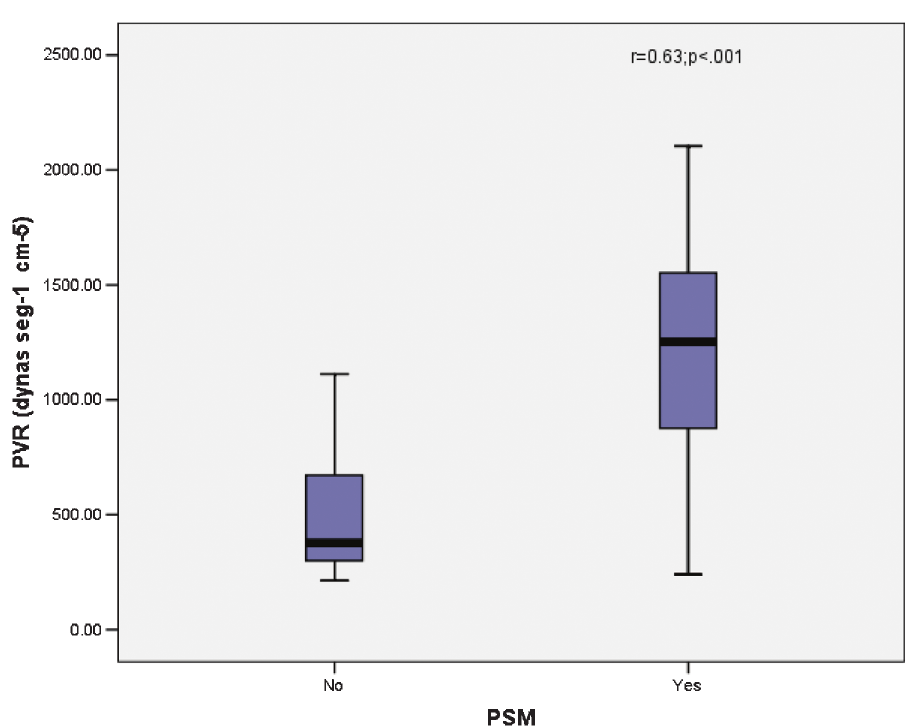
Figure 3 - Correlation between PVR and PSM.